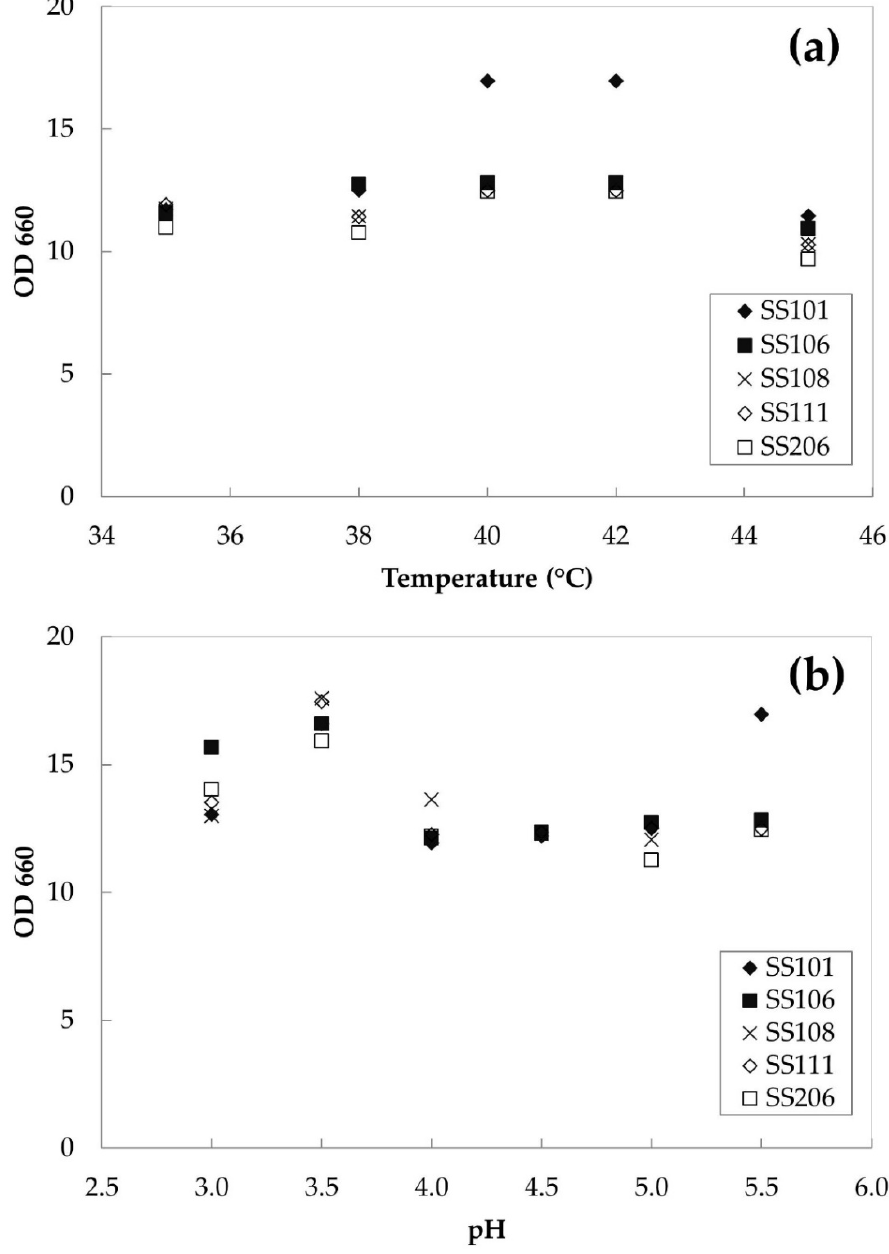
Figure 1. Effects of temperature ( a ) and pH ( b ) on cell growth (OD660) of SS101 (filled diamonds), SS106 (filled squares), SS108 (crosses), SS111 (open diamonds), and SS206 (open squares) cultivated in yeast malt (YM) medium composed of 10 g/L of glucose, shaken at 200 rpm for 24 h .